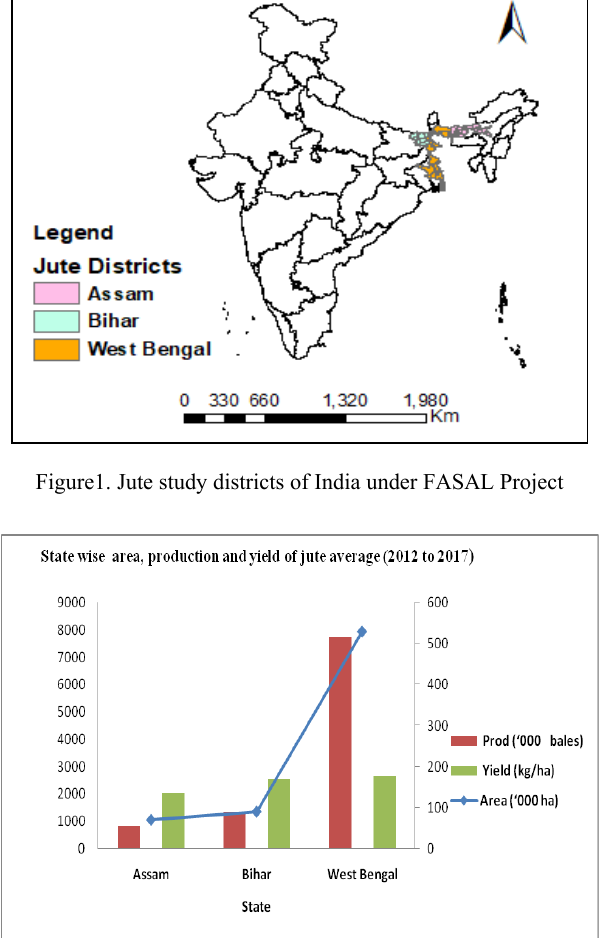
The temporal backscatter value of the jute crop was different with respect to other land cover in the study area. Its temporal Profile behaves like V shape curve. High backscatter values of built-up areas range from -2.3 to -2.1. They appear bright in all dates with little variation in db. values due to no change in